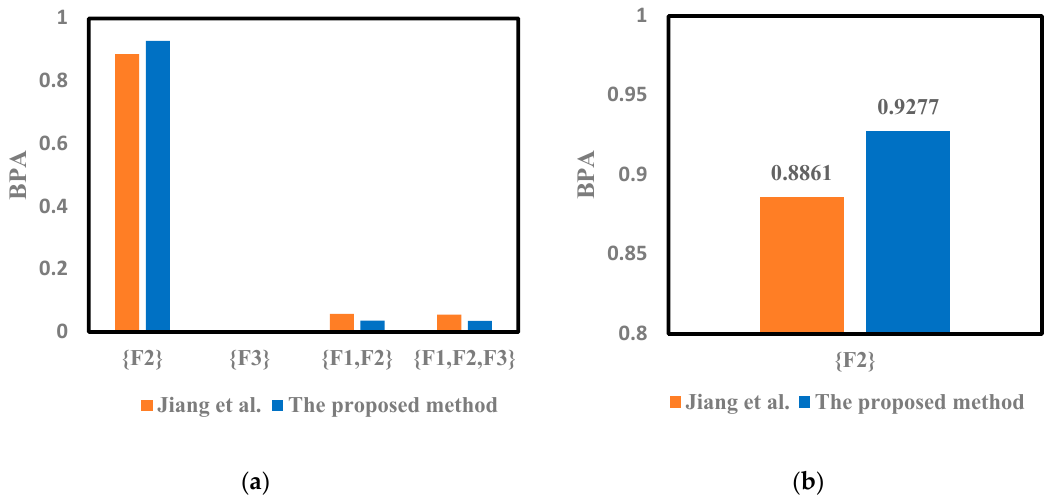
Table 5. Fusion results of different methods for motor rotor fault diagnosis at 1𝑋 frequency.